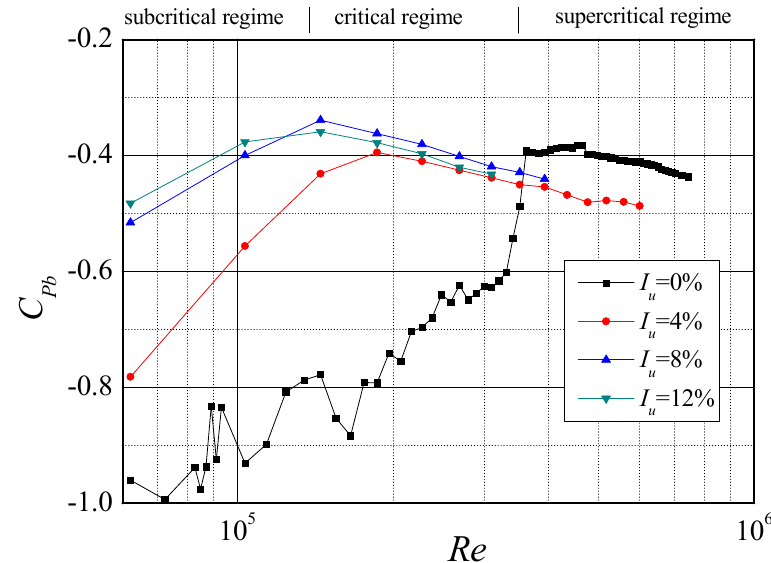
Figure 9. The mean wind pressure coe ffi cient within the base region C pb in Figure 9 . The mean wind pressure coefficient within the base region C pb in turbulent.